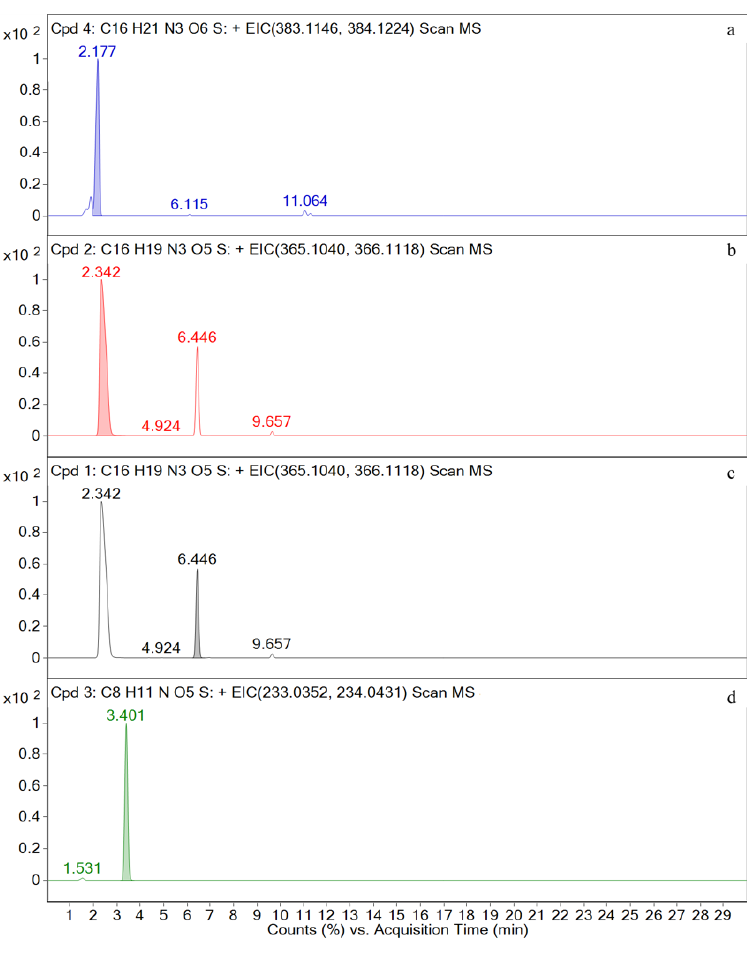
Figure 8. Ion chromatograms of urine samples. ( a ) M2; ( b ) M1; ( c ) M3; ( d ) M4. M1, M3, and M4 are detected in the kidney samples. The EIC and TIC for the kidney sample are shown in Figure 9 and Figure A2 in the Appendix A, respectively.